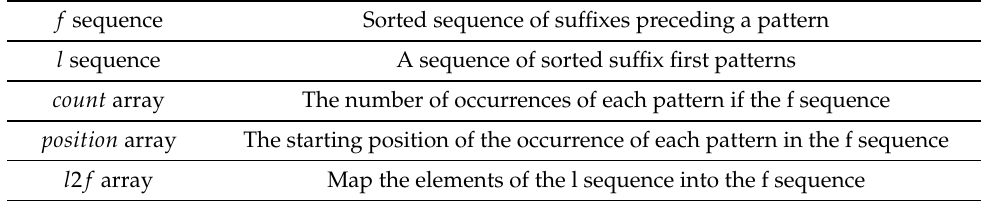
Table 2. Intermediate